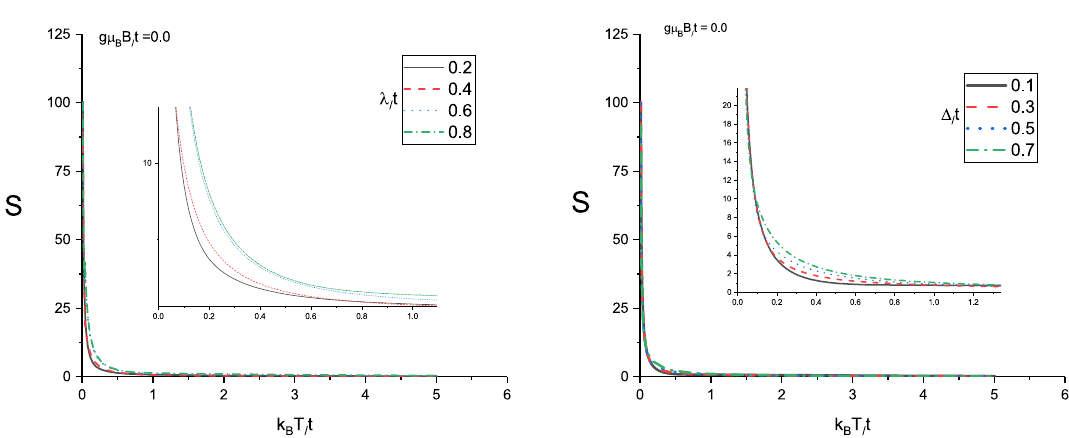
Figure 9. Left panel: Seebeck coefficient of Lieb lattice as a function of normalized temperature k B T / t for different values of normalized spin-orbit coupling (cid:31) / t in the absence of magnetic field. Normalized chemical potential and normalized gap parameter have been fixed at µ/ t = 1.0 and �/ t = 0.3 , respectively. Right Panel: Seebeck coefficient of Lieb lattice as a function of normalized temperature k B T / t for different values of normalized gap parameter �/ t in the absence of magnetic field. Normalized chemical potential and normalized spin-orbit coupling have been fixed at µ/ t = 1.0 and (cid:31) / t = 0.2 ,